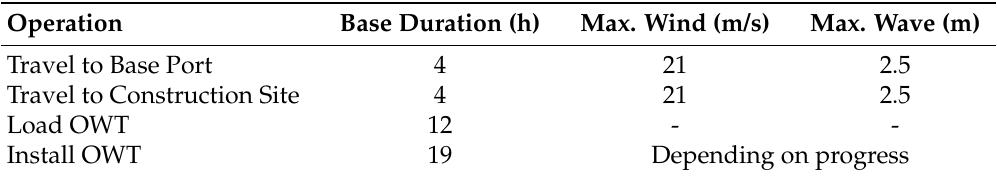
Table 3. Aggregate operations used by the MILP